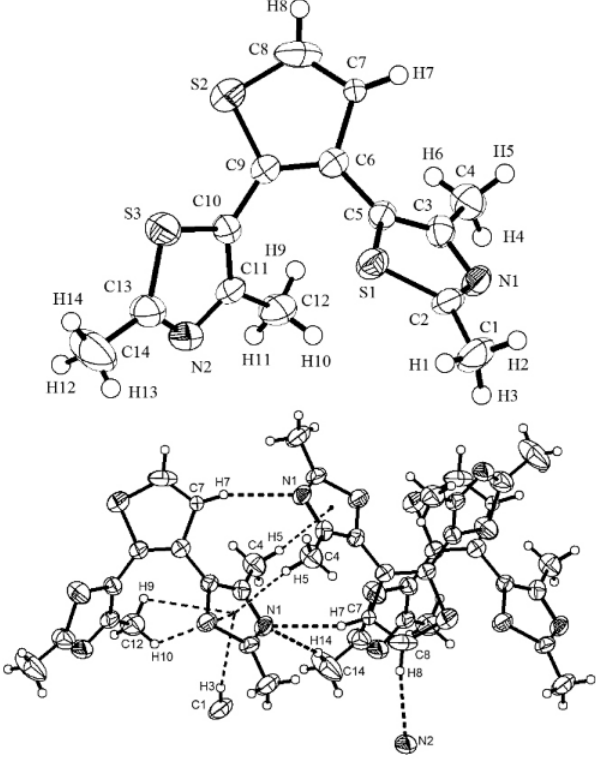
Table 1. Data collection and